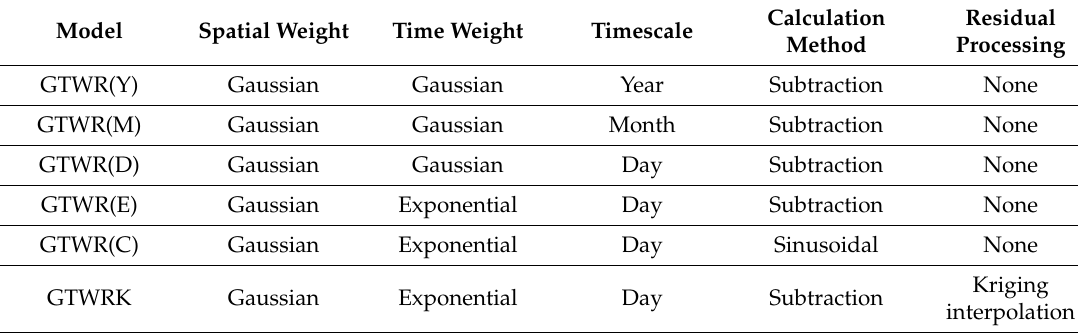
Table 1. Listing of the geographically and temporally weighted regression (GTWR) models.